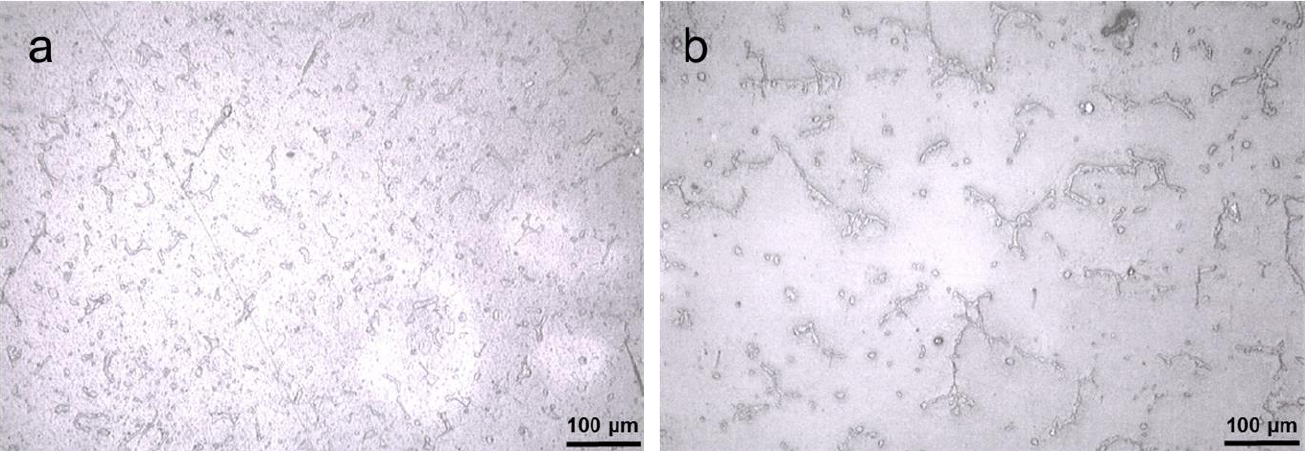
Figure 10. Microstructure images of ( a ) BJ impeller, ( b ) KSB impeller.